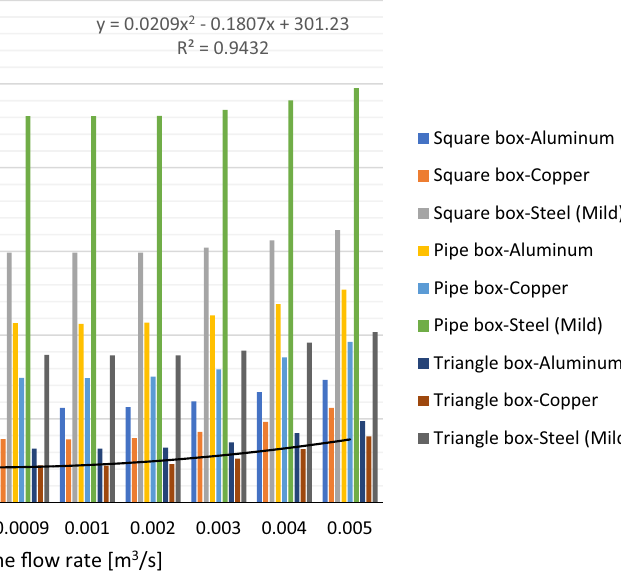
Figure 9: Collector temperature vs. volume fl ow rate.